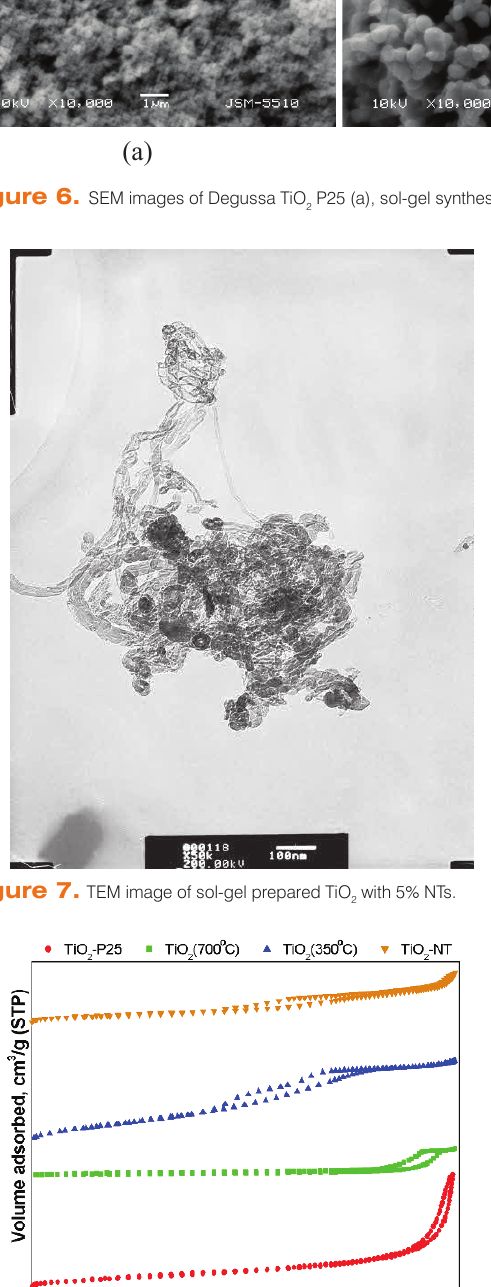
adsorption–desorption isotherms of Degussa TiO 2 sol-gel produced (at 350 and 700 o C) TiO